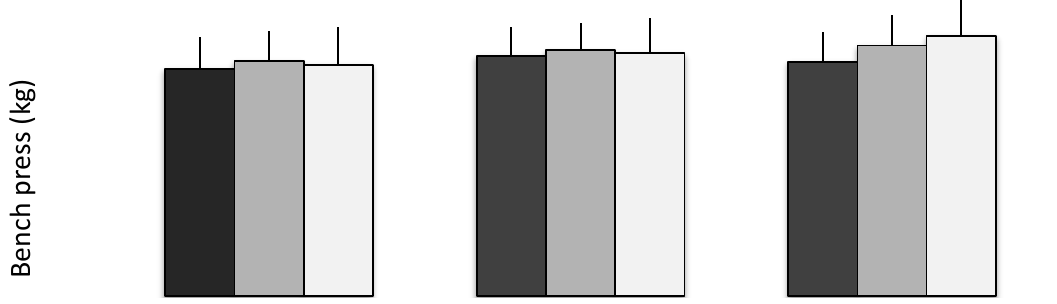
Fig 4: The comparison of means (SD) of Bench press test in the three groups. Significant among control and tapering 75% are indicated with